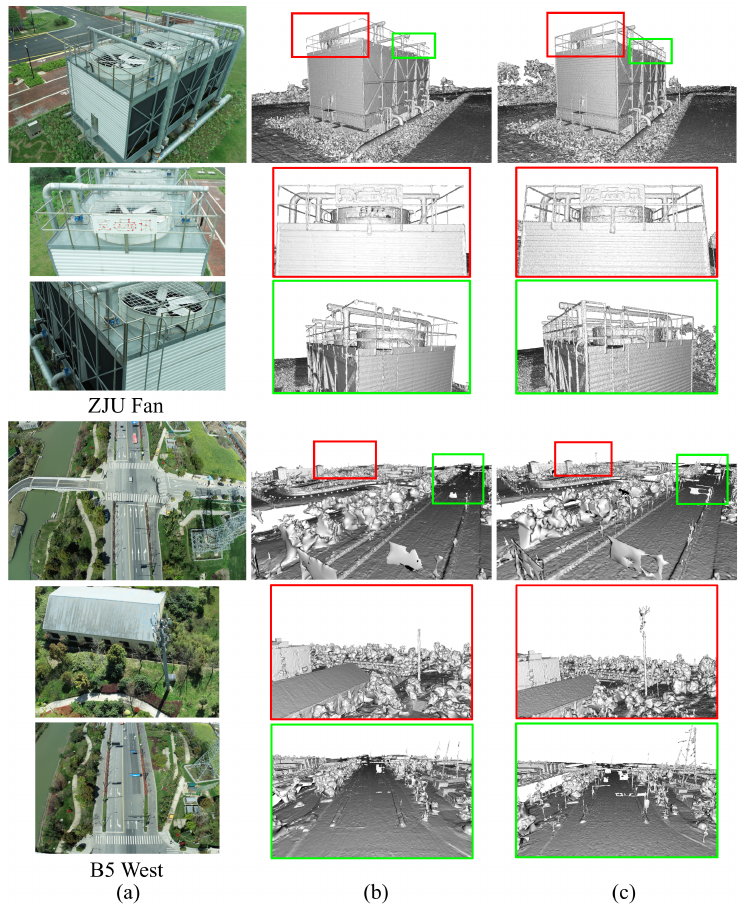
Figure 8. Comparison of our method with the third party software RealityCapture, on the cases “ZJU Fan” and “B5 West”. ( a ) Some representative source images of each case. ( b ) The reconstructed 3D models using RealityCapture. ( c ) The reconstructed 3D models by our DP-MVS. Some detailed structures are highlighted in the rectangles to show the effectiveness of our proposed